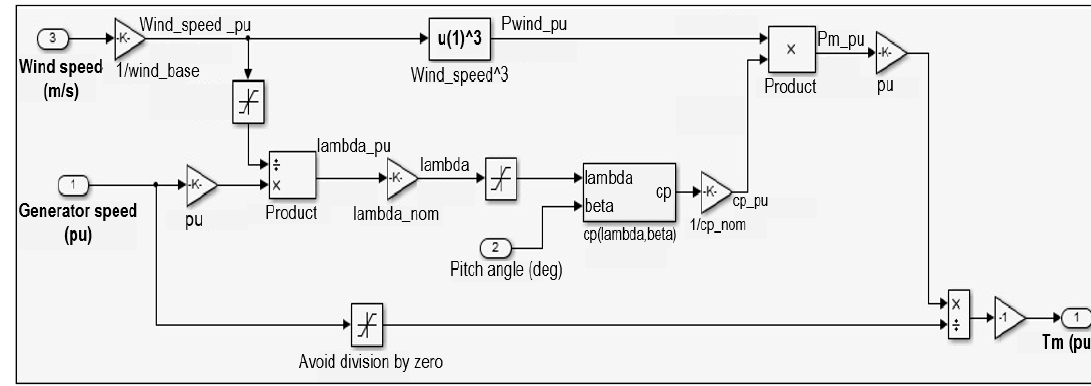
Figure 8. Wind turbine model in Simulink-Matlab software.